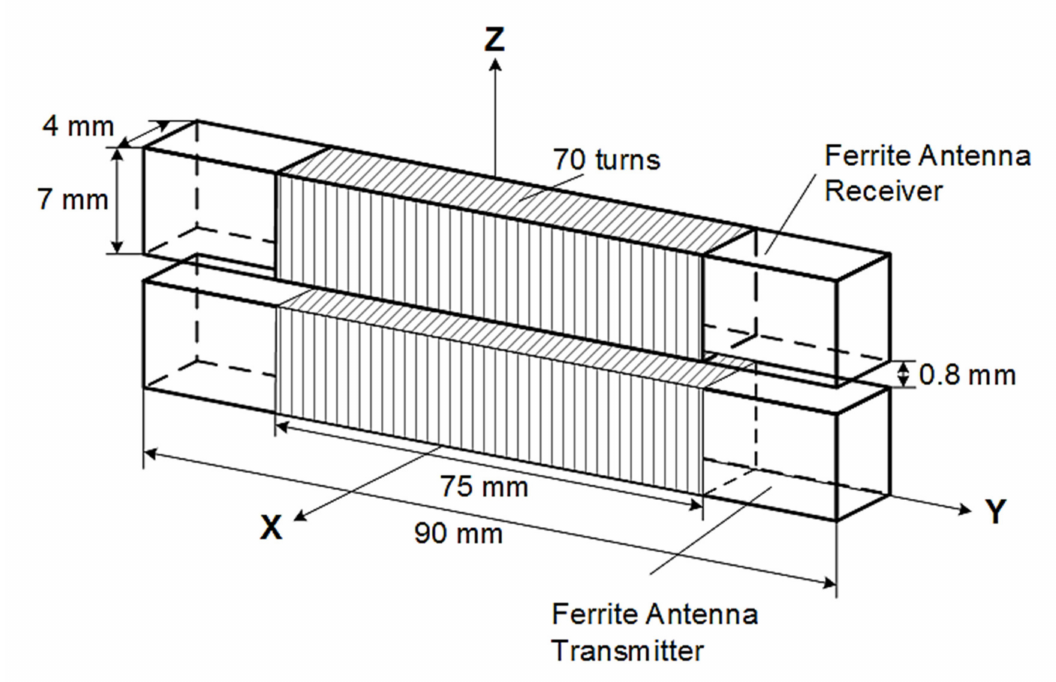
Figure 9. Geometric dimensions of the transmitter and receiver of the ferrite